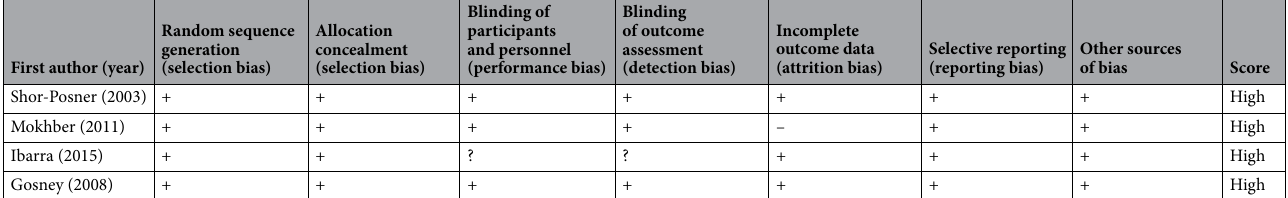
Table 2. Quality assessment of the included randomized controlled trials according to the Cochrane Collaboration Risk of Bias Tool. Symbols: +, low risk of bias; ?, unclear risk of bias; –, high risk of bias.